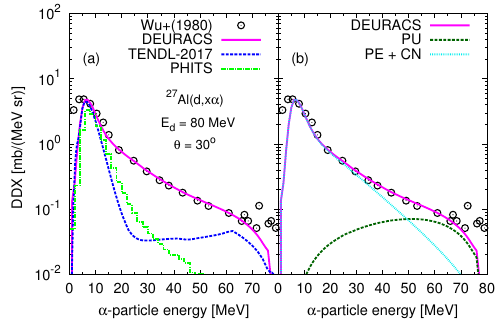
Figure 3. Same as figure 1 but for the 27 Al( d , x α ) reaction at 80 MeV. Experimental data are taken from Ref. [26].